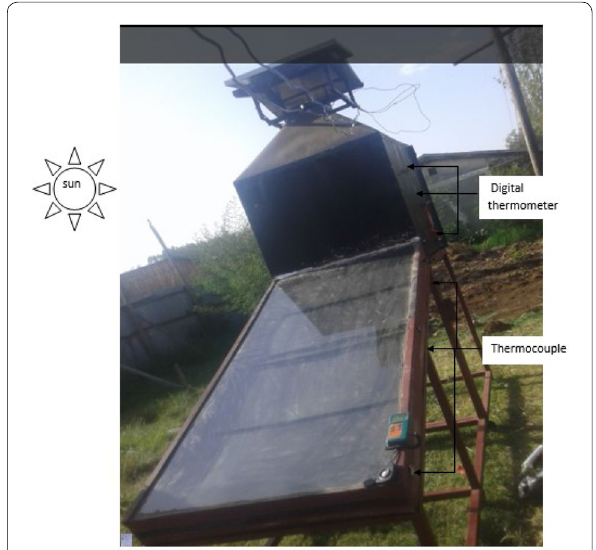
Fig. 24 Experimental setup of solar